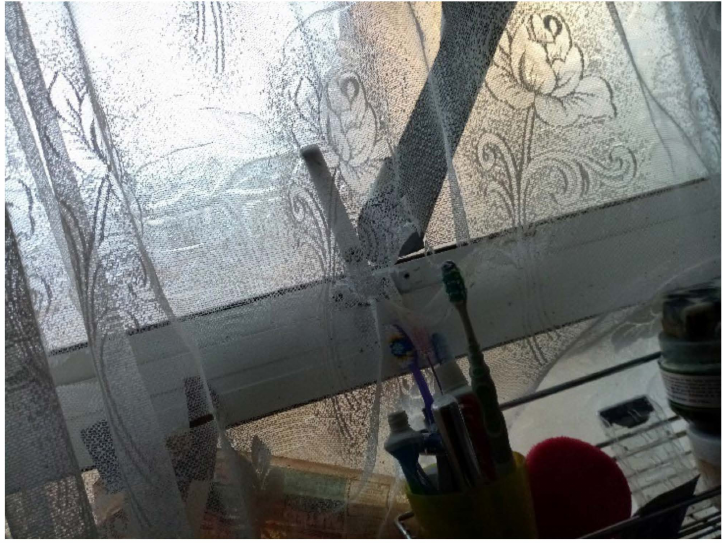
Figure 16. “Broken windows and humidity”—Participant.Survey10.